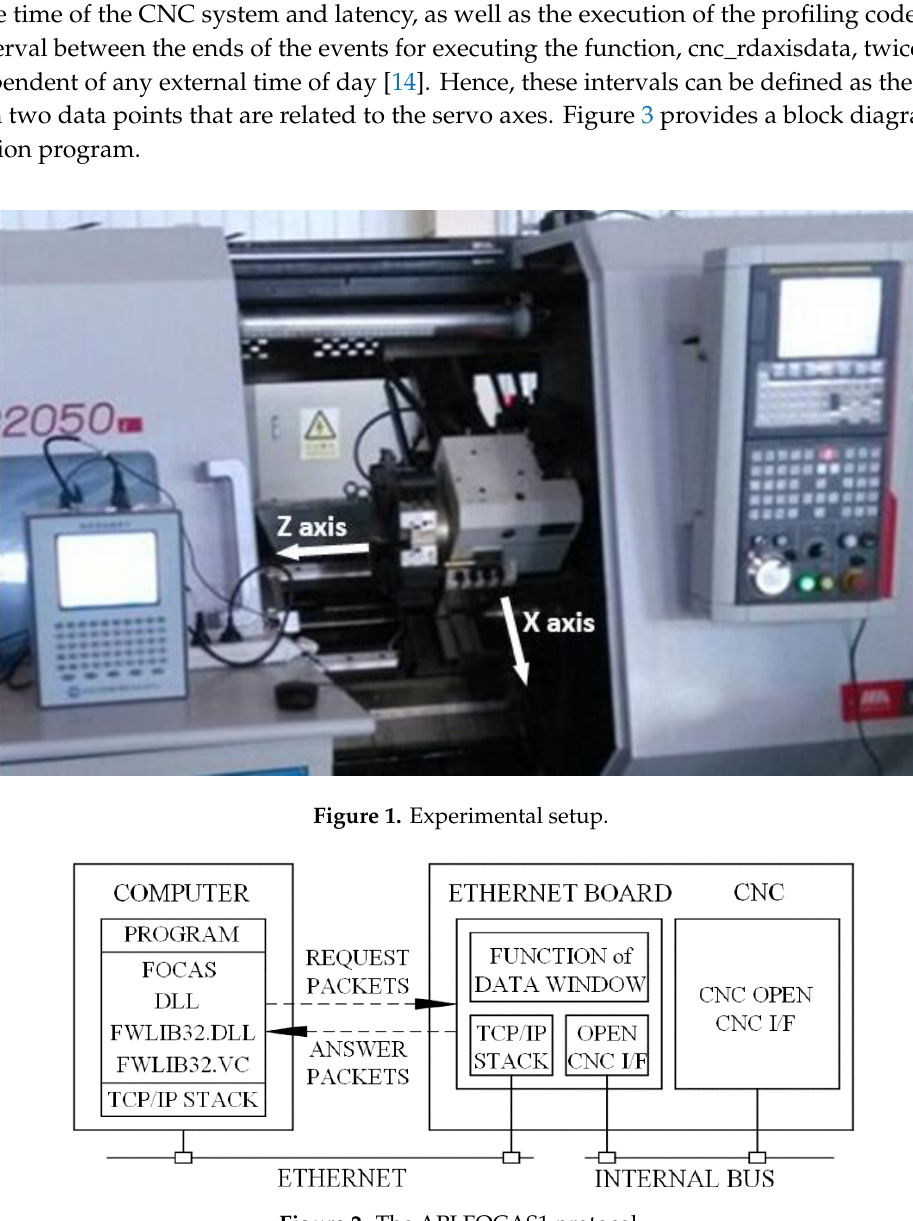
Figure 2. The API FOCAS1 protocol.